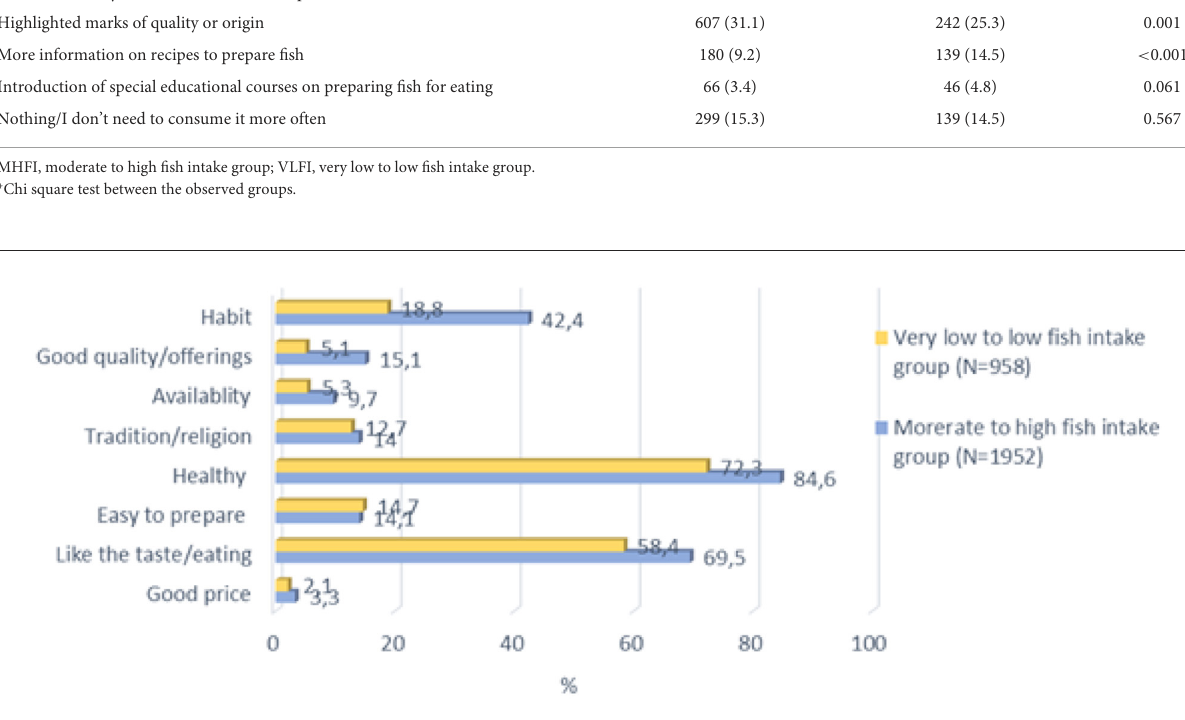
FIGURE4 Reasons to consume fish and fishery products among groups regarding the recommended fish